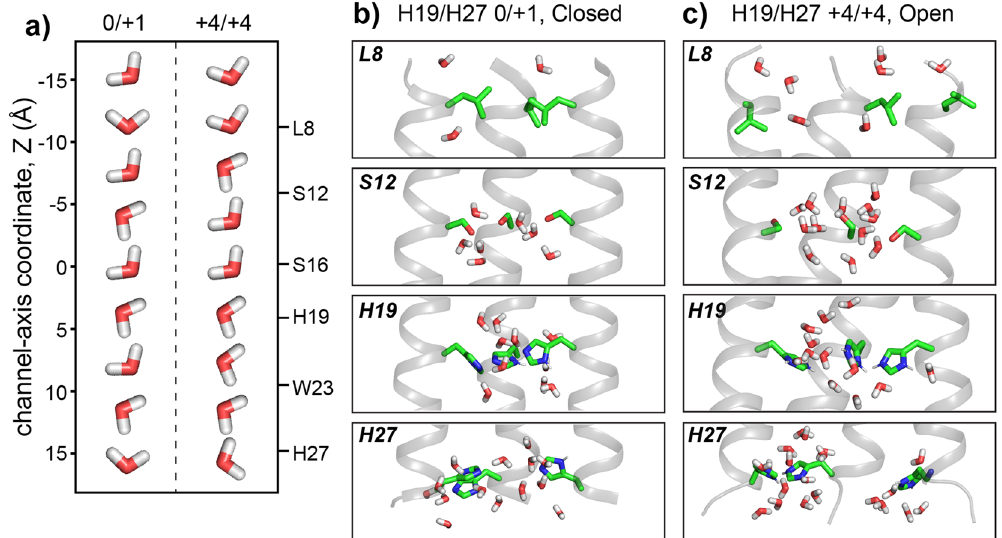
Fig. 6 Water orientations in the closed 0/ + 1 channel and the open + 4/ + 4 channel. a Most probable water orientations along the channel axis, plotted for 4 Å bins. b , c Representative snapshots of water in the b closed 0/ + 1 channel and the c open + 4/ + 4 channel. Only water within 3 Å of pore-facing residues are shown.